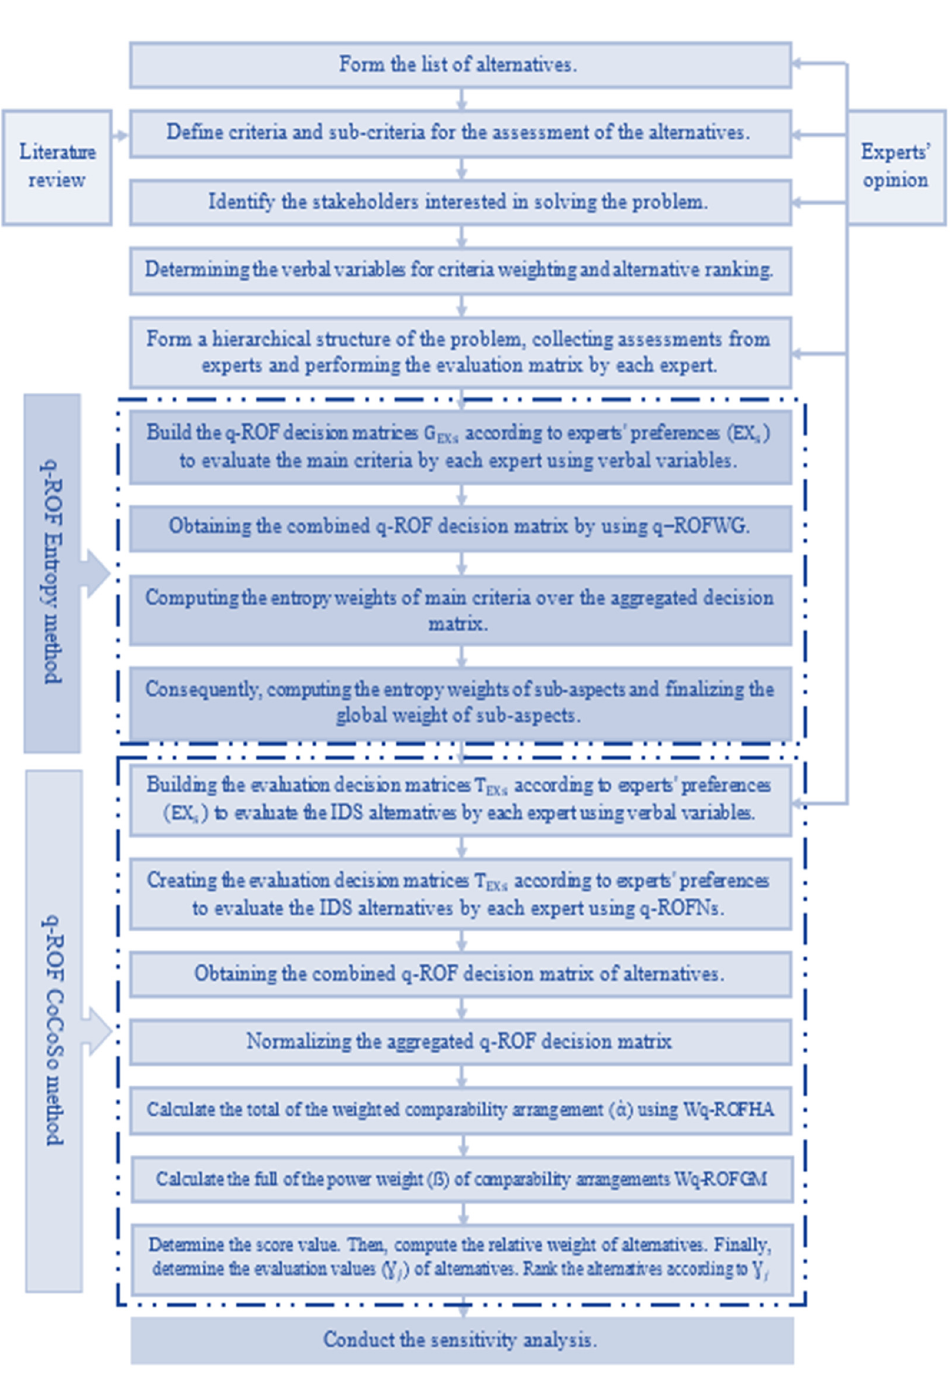
q-ROF weight of the j th criterion.